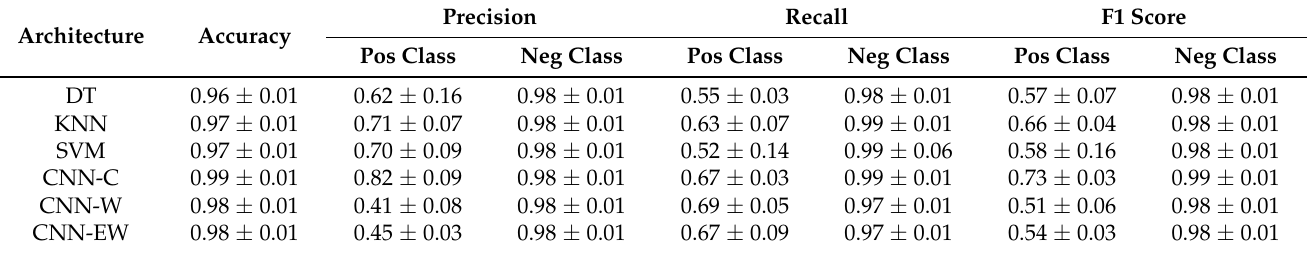
Table 1. The experimental outcome of the workflow I using all employed techniques. CNN-C stands for CNN with classification implementation, the W and EW with network name indicate the weighted SAE and extended weighted SAE regression, respectively. Pos and Neg represent the positive and the negative classes.